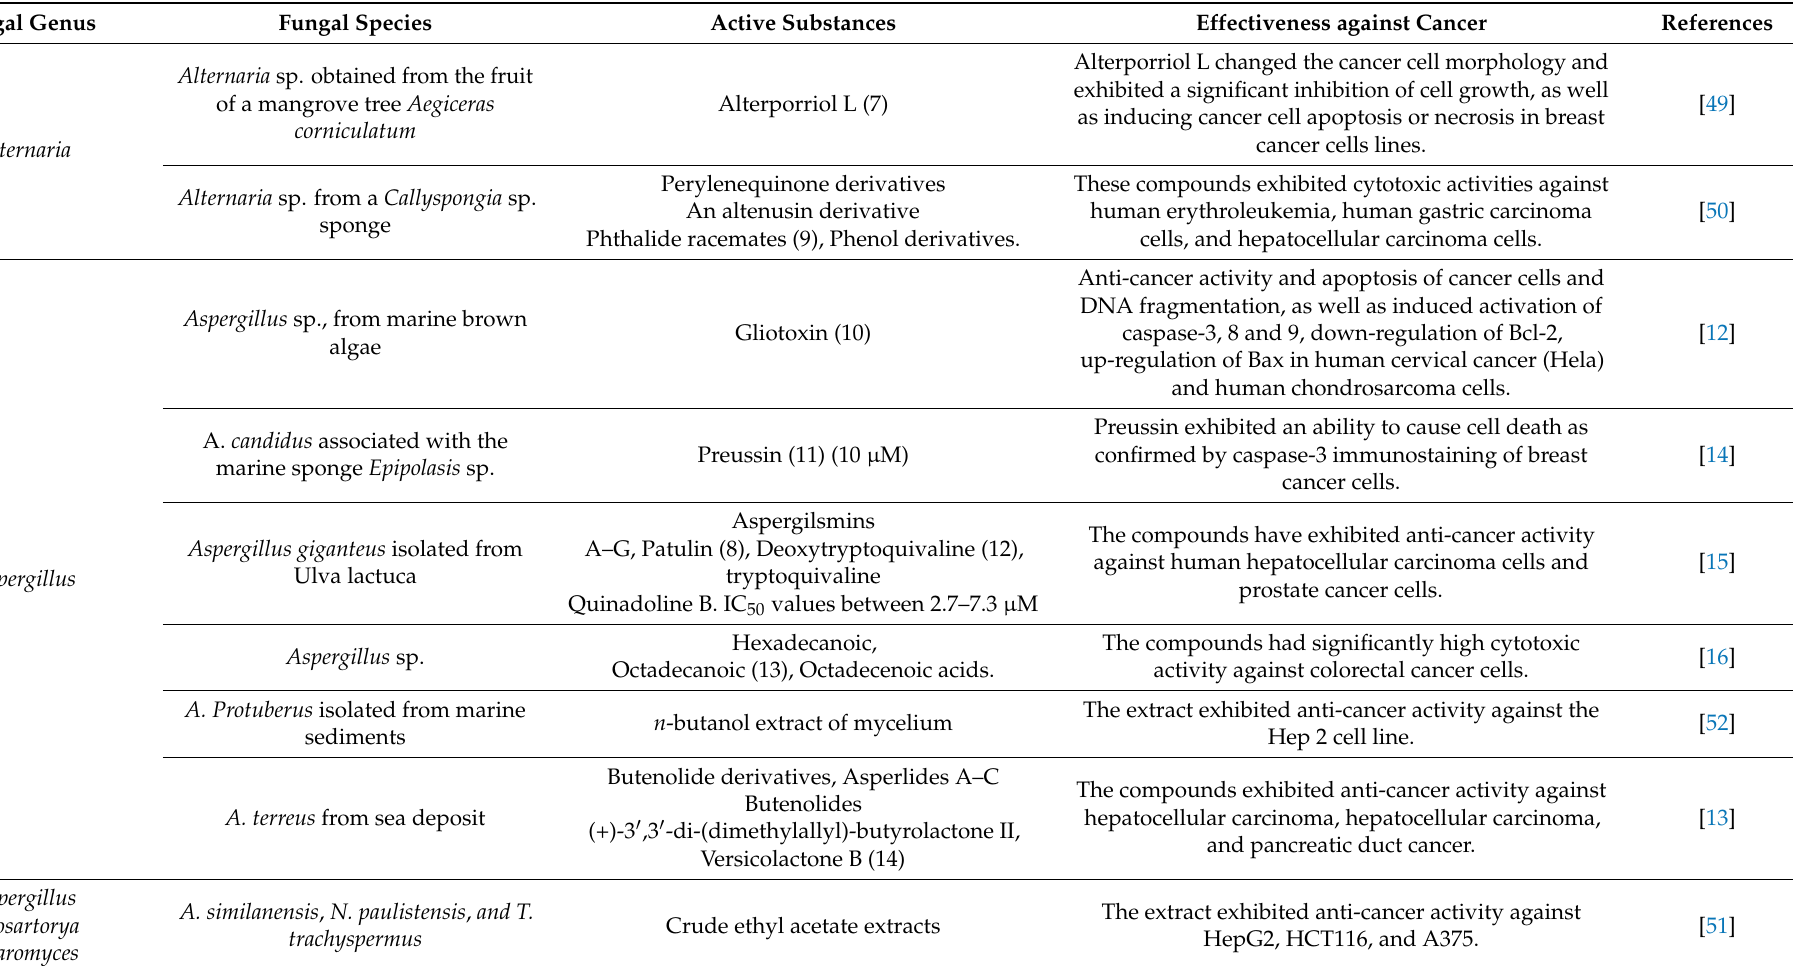
Table 5. Review of the studies conducted on the application of secondary metabolic products from fungi as anti-cancer